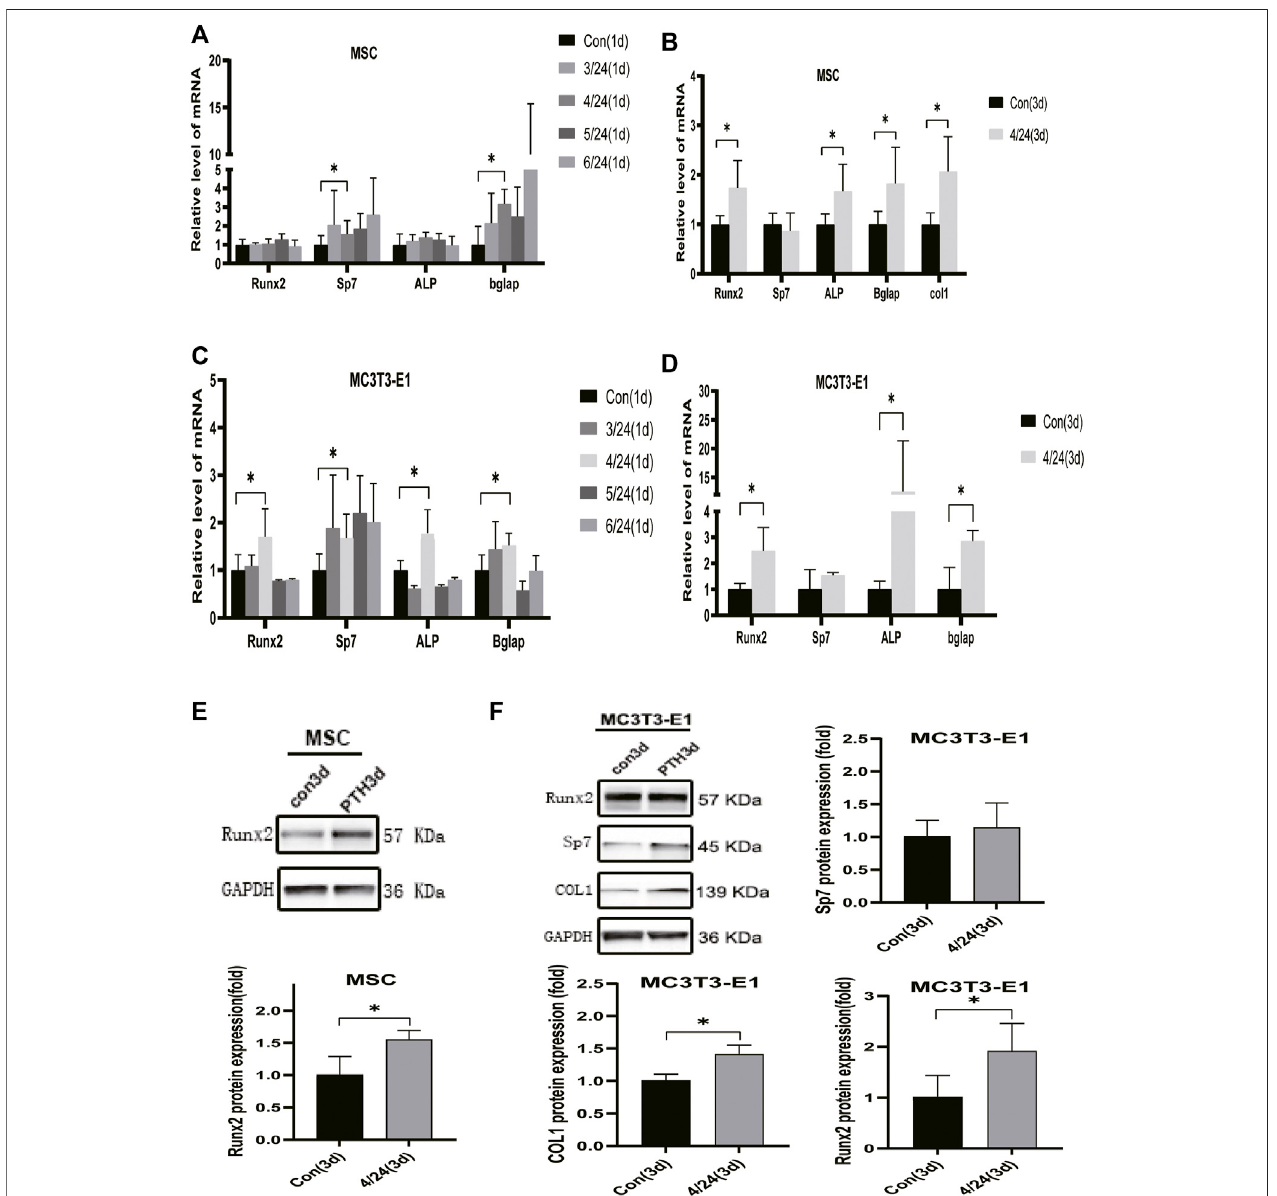
FIGURE1 | Effects ofiPTH on osteogenic differentiation of MSCsand MC3T3-E1 cells. (A) Relative mRNA expression levels of osteogenic marker genes on d one inMSCsupontreatmentwith10 nmol/mlPTH1-34for0/24h,3/24h,4/24h,5/24h,and6/24 h. (B) RelativemRNAexpressionsofosteogenicmarkergenesondthreein MSCsuponiPTHfor4/24 h. (C) Relative mRNAexpressions ofosteogenicmarker geneson doneinMC3T3-E1 cellsuponiPTH for0/24h,3/24h,4/24h, 5/24h,and6/ 24 h. (D) RelativemRNAexpressionsofosteogenicmarkergenesondthreeinMC3T3-E1cellsuponiPTHfor4/24 h. (E) RelativeproteinexpressionofRunx2ond three in MSCs upon iPTH for 4/24 h. (F) Relative protein expressions of osteogenic markers on d three in MC3T3-E1 cells upon iPTH for 4/24 h. * p < 0.05.